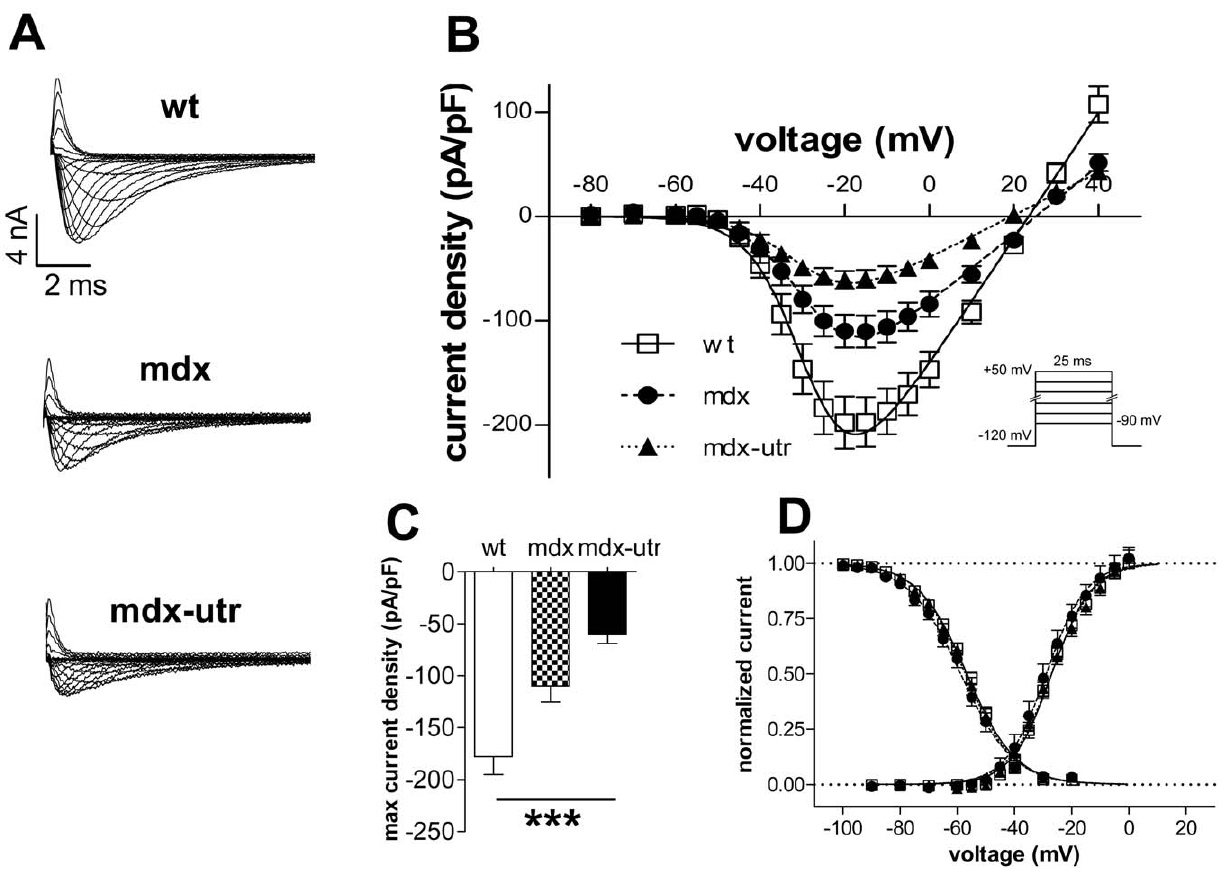
Figure 3. Sodium channel properties in wt and dystrophic adult cardiomyocytes. A. Original current traces of a typical wt, mdx, and mdx- utr cardiomyocyte, elicited by the pulse protocol in B. B. Current-voltage relationships derived from a series of experiments as shown in A. C. Maximum current densities in wt and dystrophic cardiomyocytes. *** indicates that ANOVA revealed a significant difference (p , 0.001) between the three tested groups. D. Comparison of the voltage-dependencies of activation and steady-state inactivation between wt and dystrophic cardiomyocytes. For detailed statistics and n-values see Table 1.